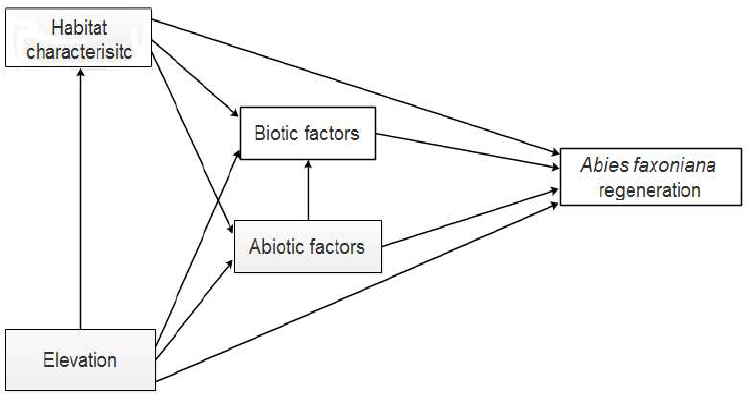
Figure 2. A priori hypothetical model of SEM. A general model of the connection between the indicators. Habitat characteristics included gap vs. CK and gap area; Abies faxoniana Rehd. et Wils. regeneration included the density of Abies faxoniana saplings, density of Abies faxoniana small trees, and the HD ratio of the tallest Abies faxoniana small trees.